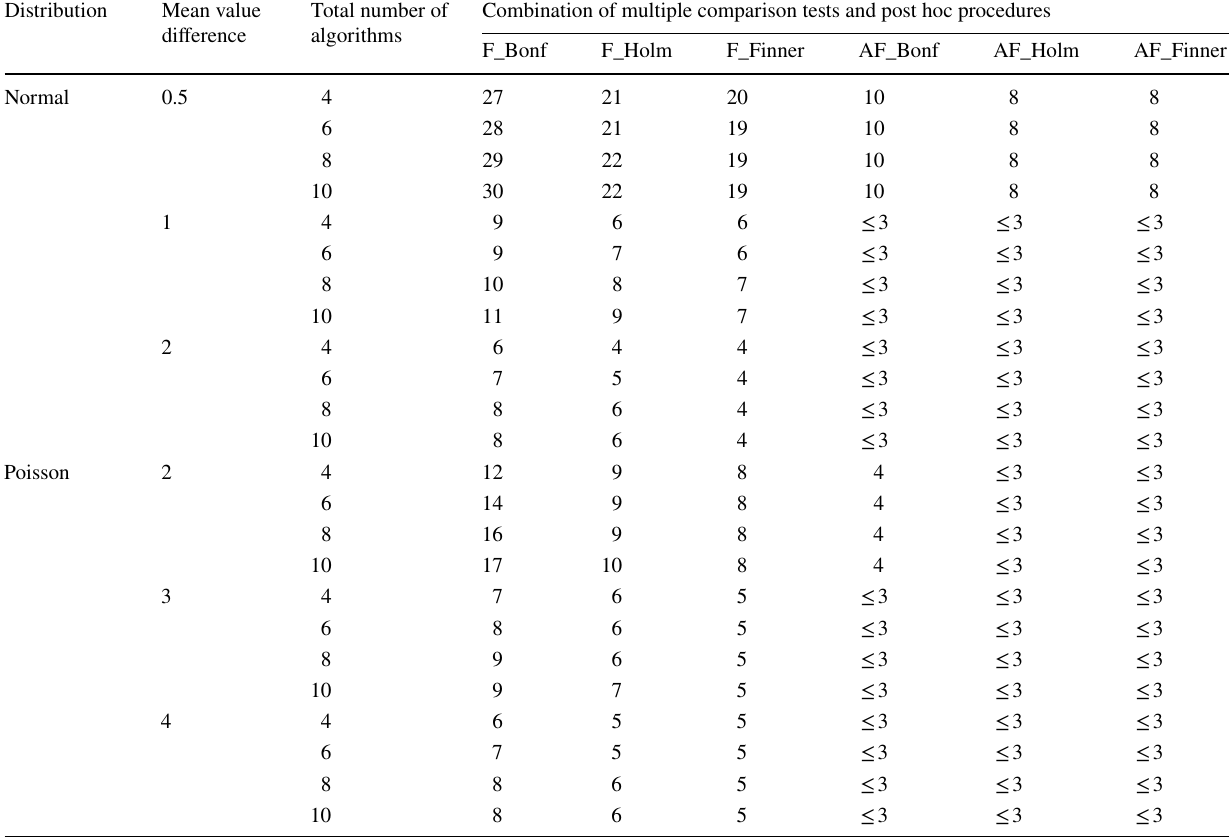
Table 5 The minimum number of datasets required by different nonparametric statistical tests for rejecting the null hypothesis with a signifi- cance level of 0.05, under the experimental settings i-iii and v-vii